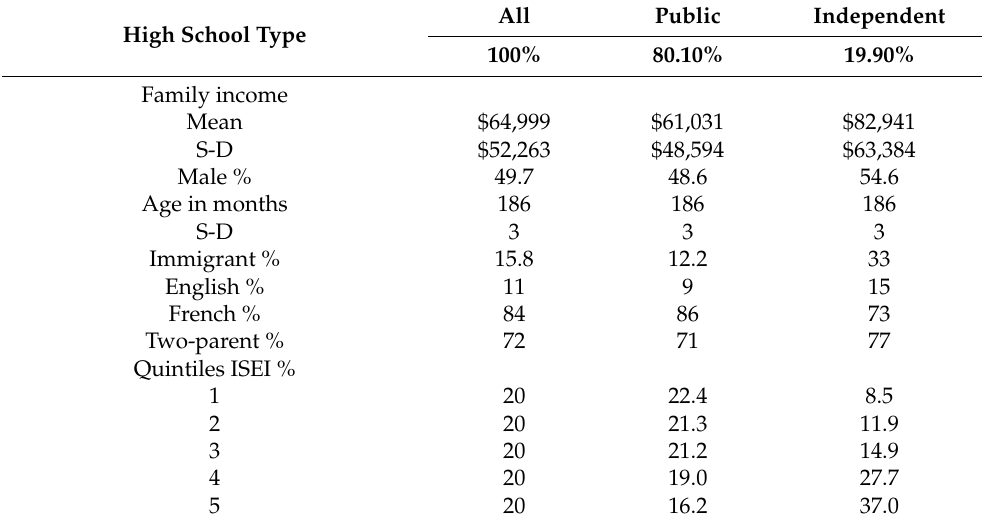
Table 3. Mean characteristics of respondents by type of high school, cohort A cycles